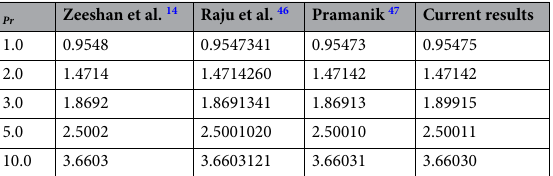
Table 5. Visualizes the comparison of current results with previous published results for the various values of Pr = 1.0, 2.0, 3.0, 5.0, 10.0.